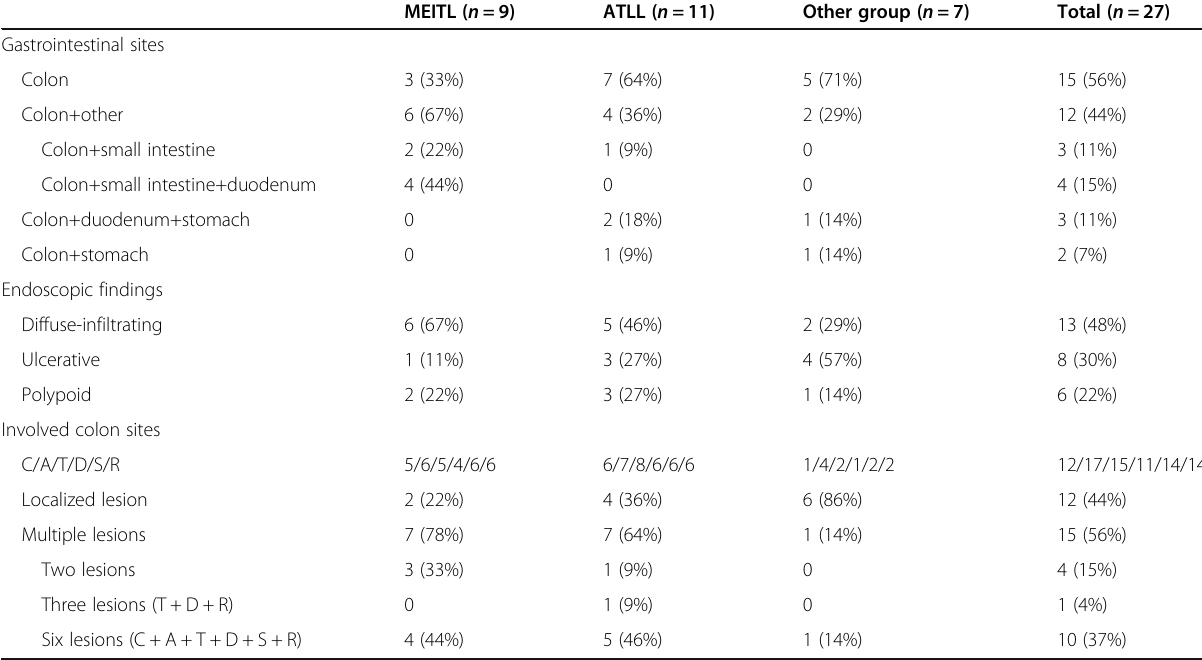
Table 2 Involved gastrointestinal sites and endoscopic findings in 27 colorectal T/NK cell lymphoma patients